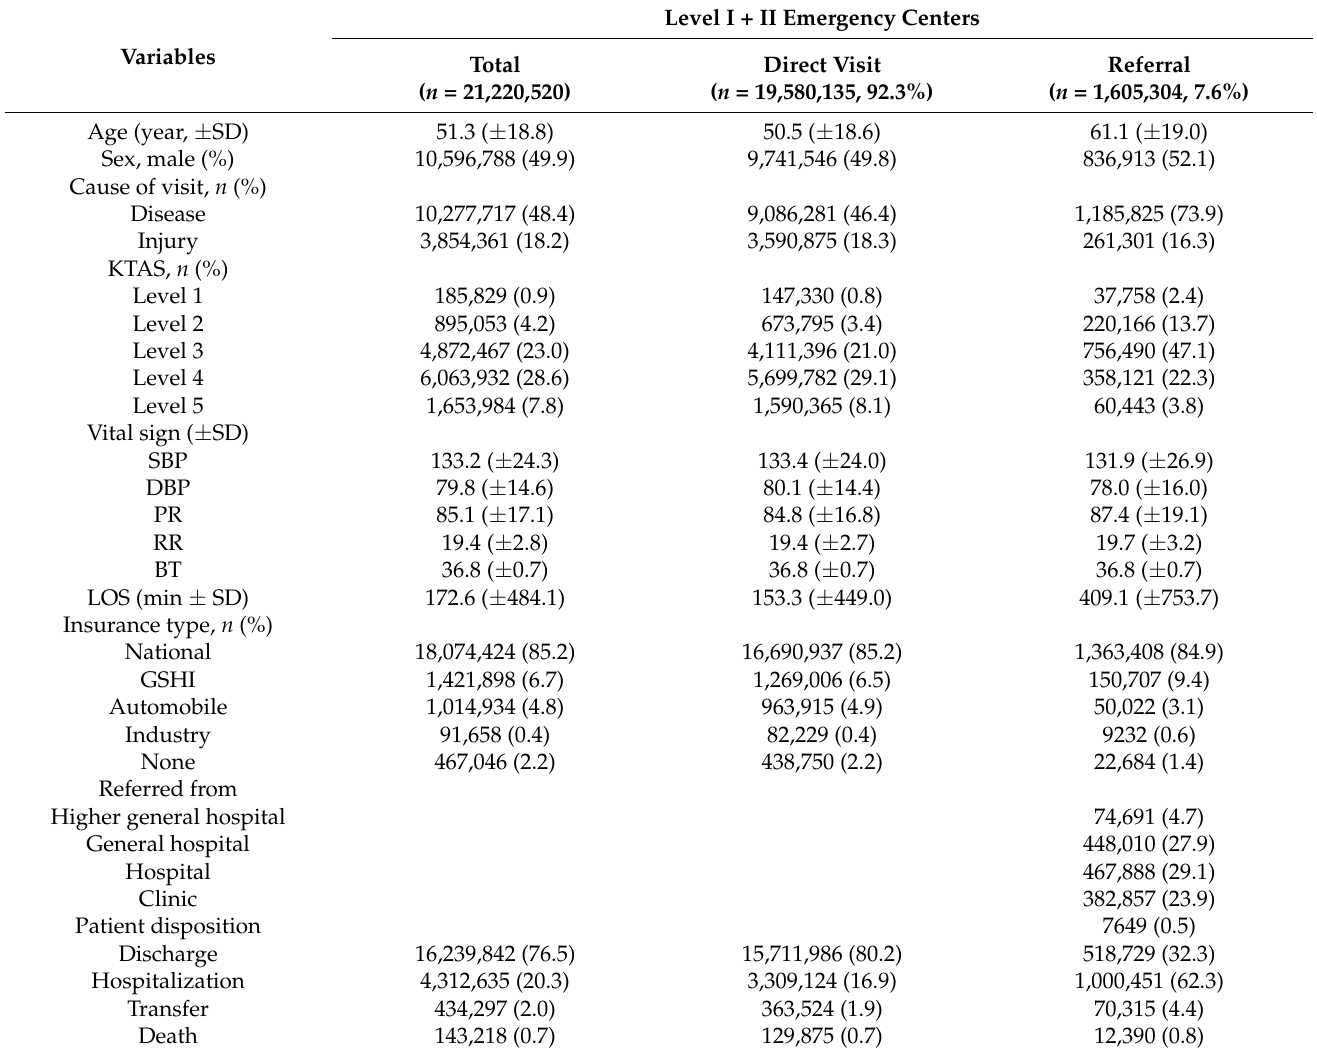
Table 1. Clinical characteristics and outcomes of direct visits vs. referrals at level I and II emergency